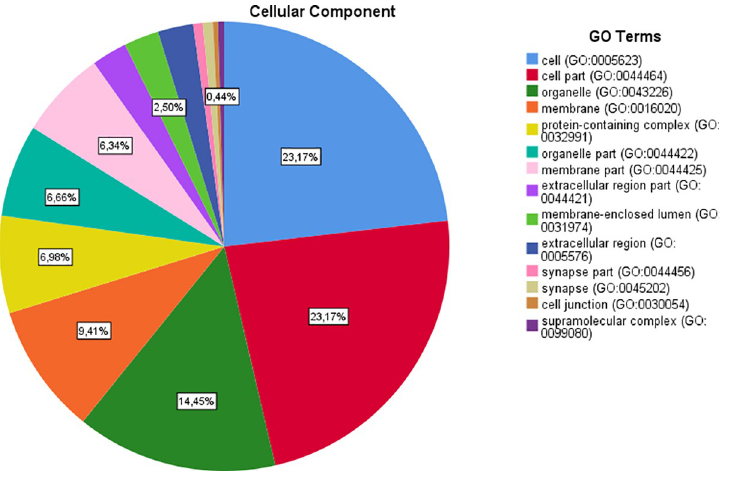
Fig 4. Results of “cellular component” category.